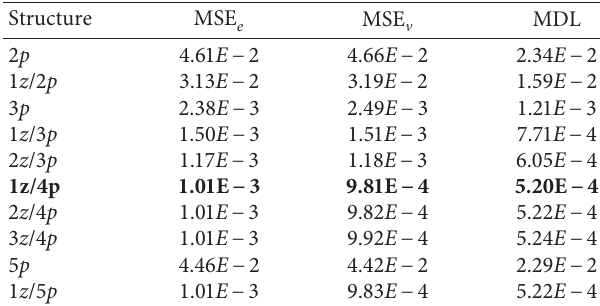
Figure 10: Input (black dashed line) and output (blue solid line) data for initial linear model estimation (numerical example 1). Table 3: Ranking of estimated linear models for numerical example 1 (Wiener system). Models 4 p , 2 z /5 p , 3 z /5 p , and 4 z /5 p have been excluded due to their high MCL values.